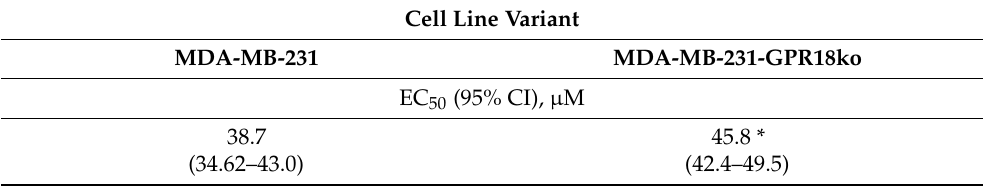
Table 3. The effect of GPR18 receptor knockout on DHA-DA cytotoxicity. Incubation 24 h; MTT test.